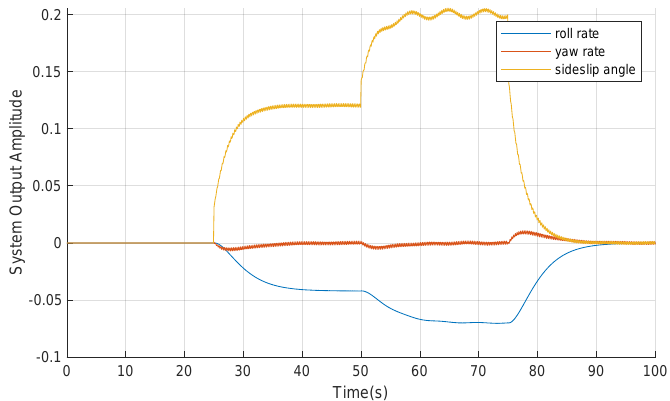
Figure 2. System output observation